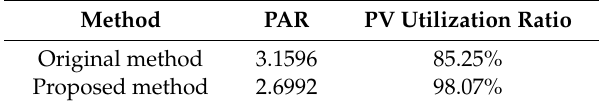
Table 2. Comparison of pea-to-average ratio (PAR) and PV utilization ratio.